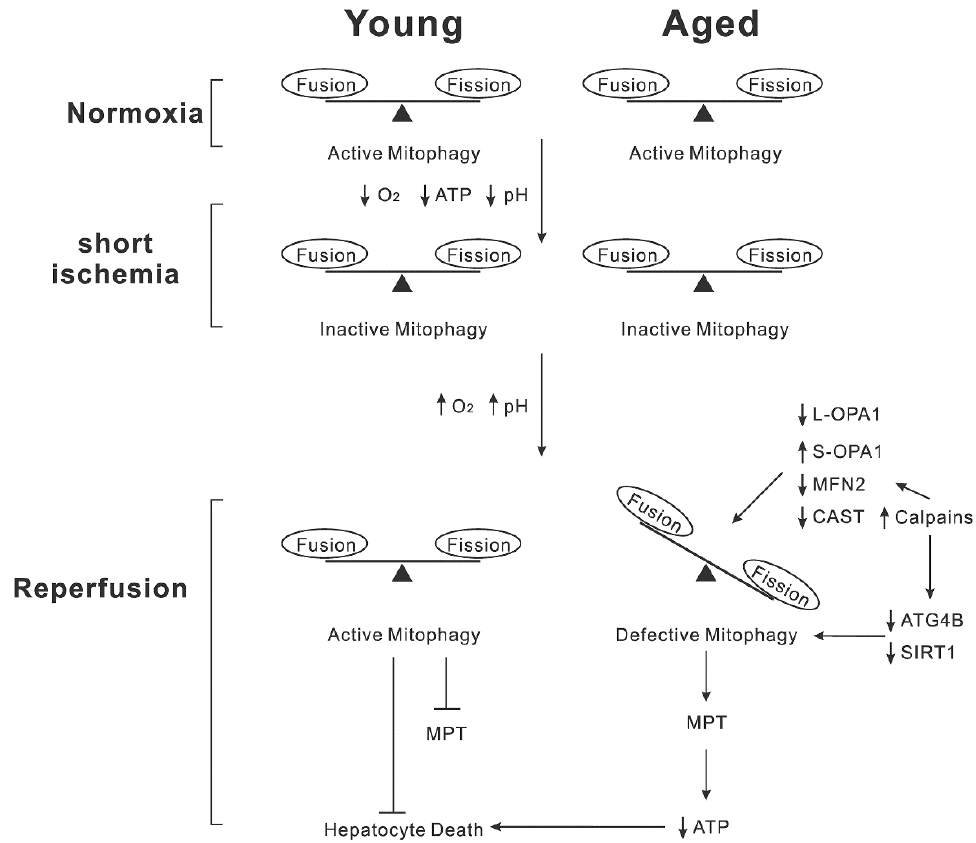
Figure 1. Proposed mechanism of aged hepatocyte death after I/R. During normoxia, both young and aged hepatocytes sustain mitophagy and the bal- ance between mitochondrial fusion and fission. During ischemia, hepatocytes encounter anoxia, ATP loss, and tissue acidosis. Short ischemia minimally affects mitochondrial dynamics in both young and aged cells. Autophagy, a highly energy-dependent cellular event, becomes inactive due to a lack of ATP during ischemia. At this time, ischemic acido- sis blocks the onset of MPT. Reperfusion restores normal pH levels and resumes